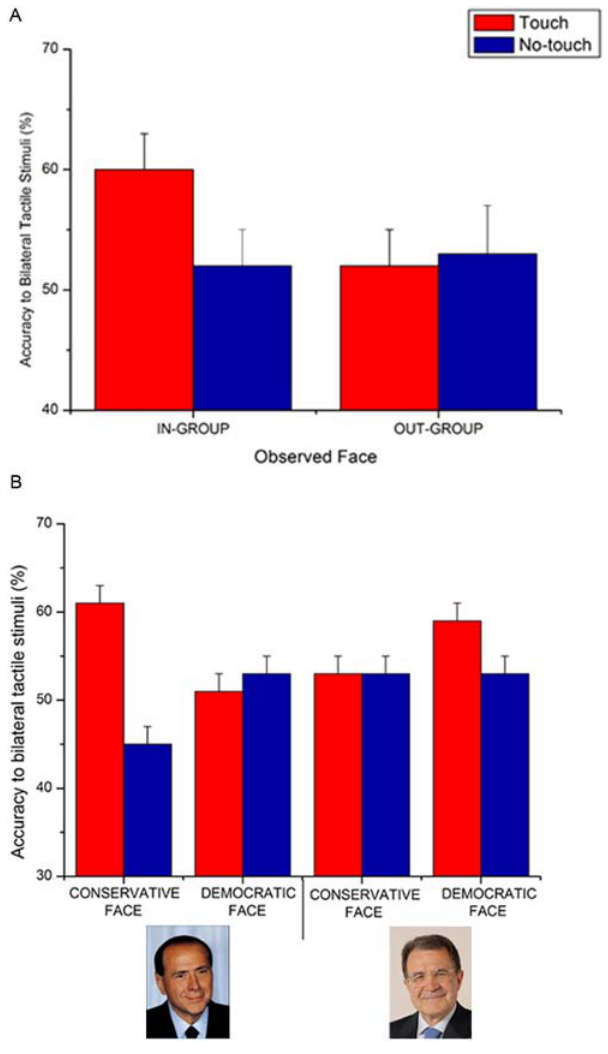
Figure 3. Visual enhancement of touch depends on the Political similarity between the observed and observer’s face. Panel A: Tactile perception was enhanced when observers belonging to Democratic and Conservative parties viewed the face of a member of their own political party (In-group) rather than of the opposite (Out- group) political party. Panel B reports data from Conservative and Democratic observers plotted separately.